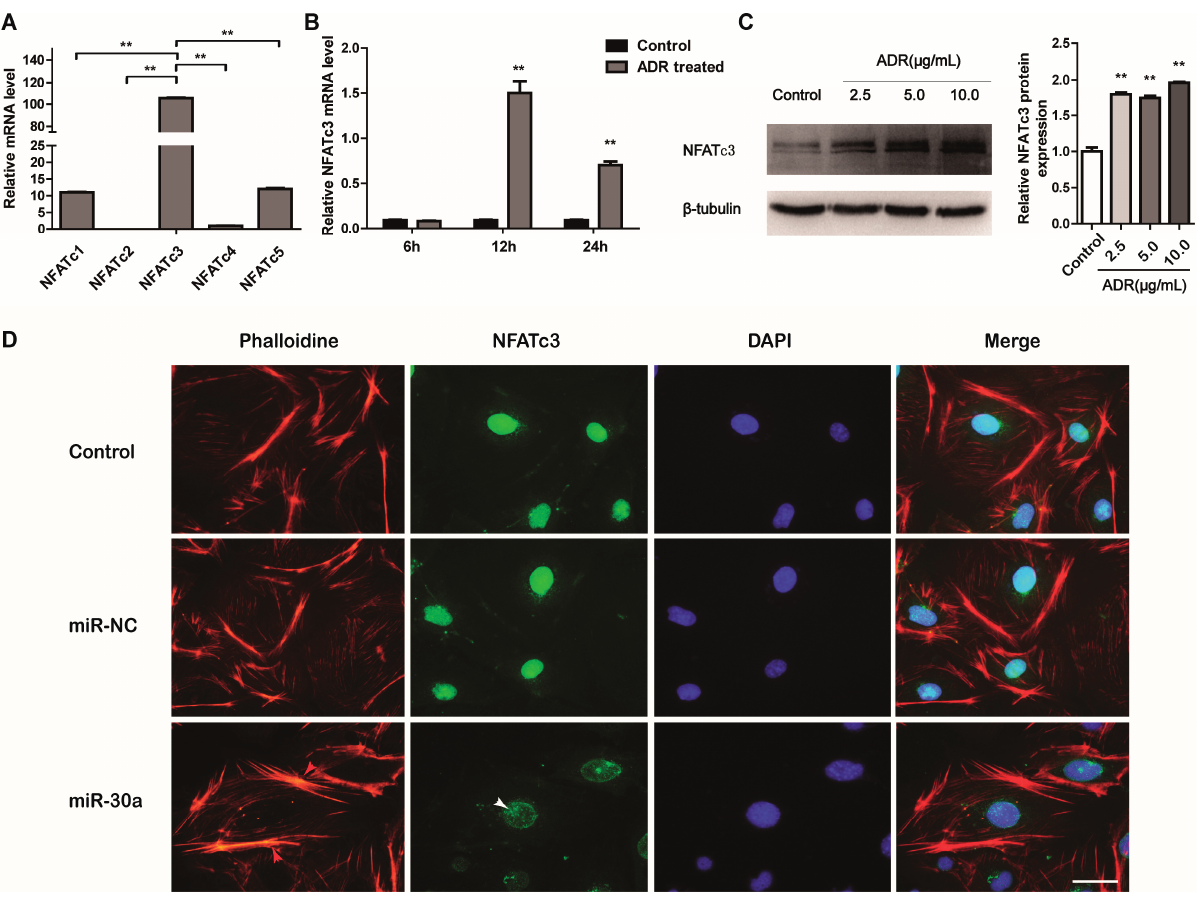
Figure 4. NFATc3 is Upregulated in Podocyte Injury. ( A ) NFAT family expression